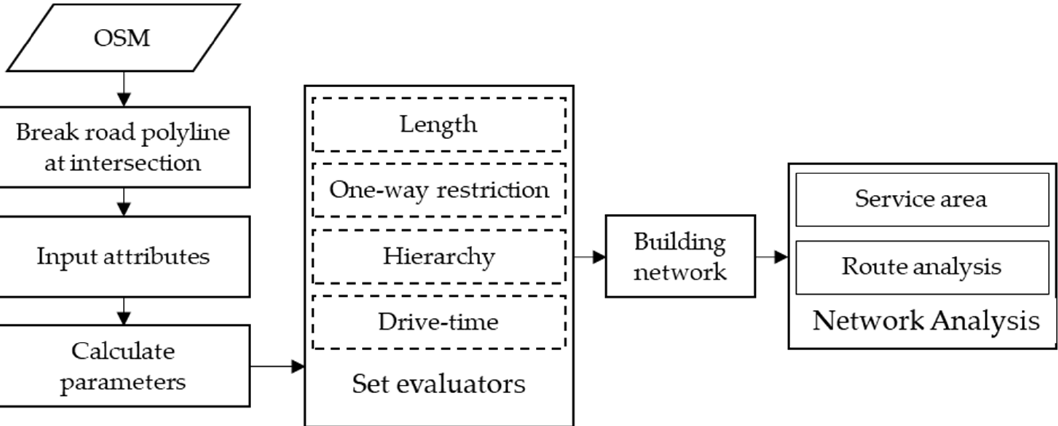
Figure 3. Network Analysis Procedure.